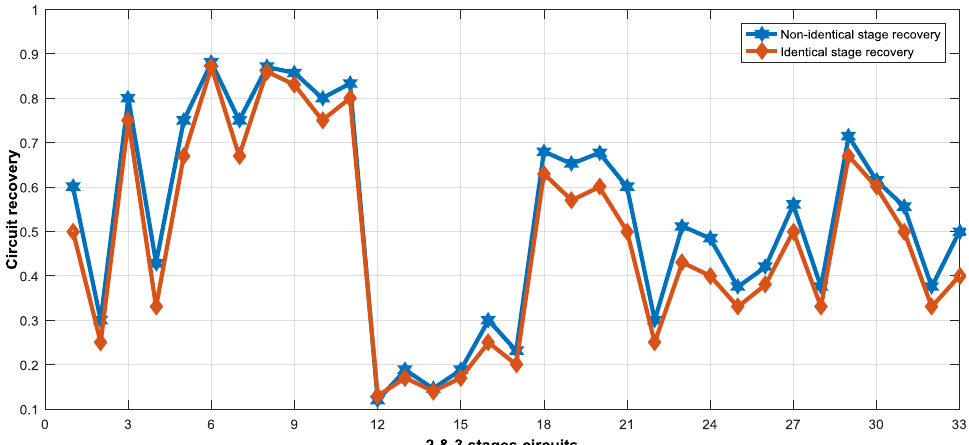
Figure 5. Comparison of the overall circuit recovery for two and three stages circuits in the case of